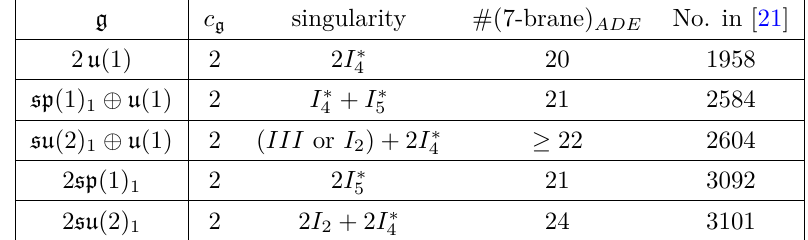
Table 7 . The gauge algebras of theories with Rank = 2 . The subscript is the level of the algebra, which is determined by the 1 -brane bound c su (1) comes from I 2